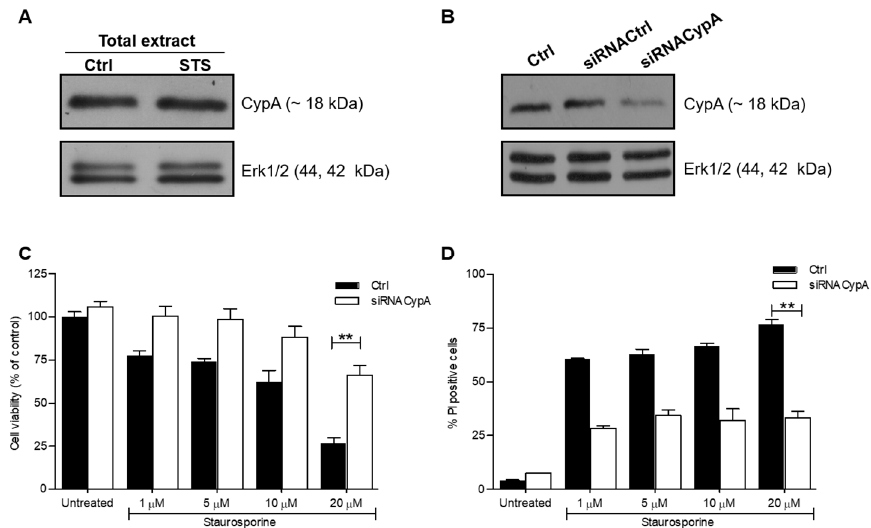
Figure 1. CypA-silencing inhibited STS-induced cell death in SH-SY5Y cells. ( A ) WB evaluation of the expression level of CypA in SH-SY5Y cells untreated and treated for 3 h with 10 µ M of STS. ( B ) WB evaluation of CypA expression level after transfection of CypA small interfering RNA (siRNACypA). Erk1/2 proteins were used as a loading control. ( C ) MTT viability assay of SH-SY5Y transfected with siRNACtrl (Ctrl) and siRNACypA exposed to STS for 3 h at the indicated concentrations, (n = 8, p ** < 0.01). ( D ) Quantification of flow cytometry results of PI stained SH-SY5Y cells, transfected with siRNACtrl (Ctrl) or with the siRNACypA and treated with STS for 3 h at 10 µM, (n = 8, p ** < 0.01).